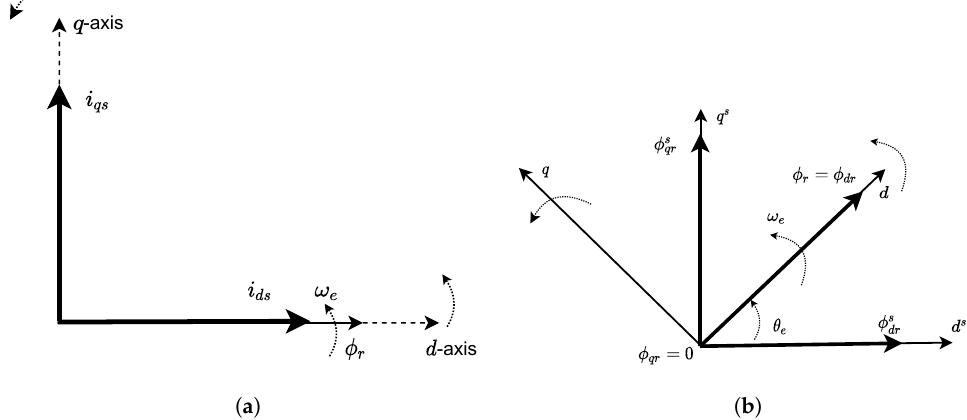
Figure 2. Rotor flux-oriented control of the IM. ( a ) Alignment of the rotor flux. ( b ) Rotor flux angle